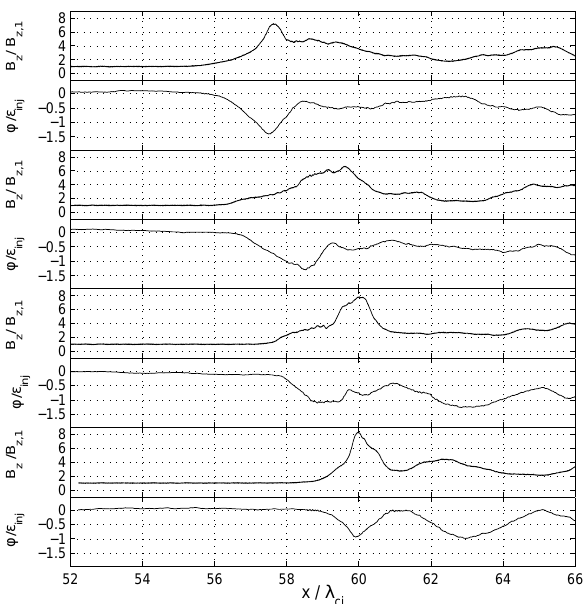
Fig. 6. Four pairs of panels, showing perpendicular magnetic field strength (upper panel of each pair), and φ = R E x dx (lower panels) in the shock region for a simulation in the absence of pickup ions. The panels are separated by equal time intervals of 0 . 4 × 2 πω − 1 , ci starting at time t = 33 . 3 × 2 πω − 1 (lowest two panels). ci